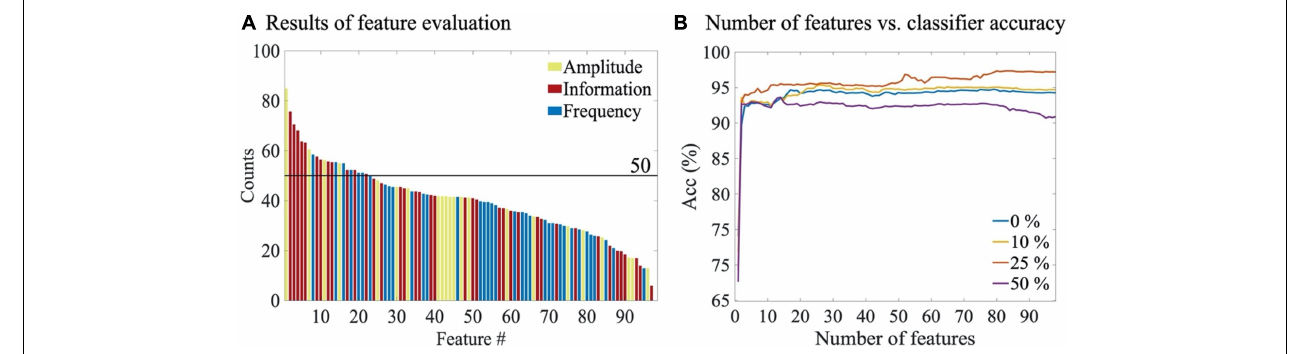
FIGURE 5 | Feature selection results. (A) The average number of times each feature was selected through all artefact rejection thresholds. Colouring refers to the feature categories (B) The overall accuracy of SVM classifiers as the number of features is increased (also Supplementary Table 3 ). Results are shown for different artefact rejection